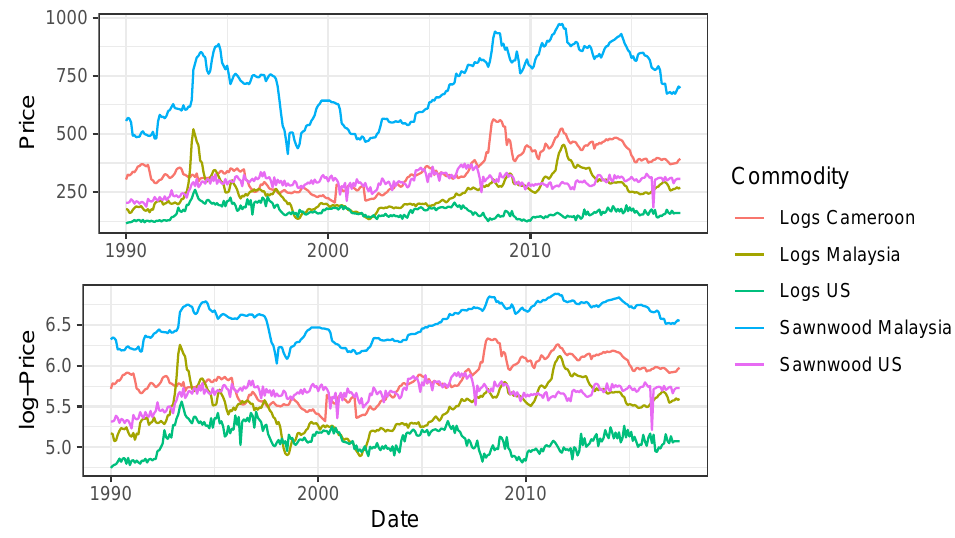
Figure 1. Price Series for Forest Products in Levels and in the Natural Logarithm in Cameroon, Malaysia and the US. The data covers a set of monthly average prices ranging from January 1990 to November 2019. The prices are expressed in US dollars per cubic meter. Foreign and domestic prices were collected from the United Nations Conference on Trade and Development (UNCTAD), IndexMundi and the World